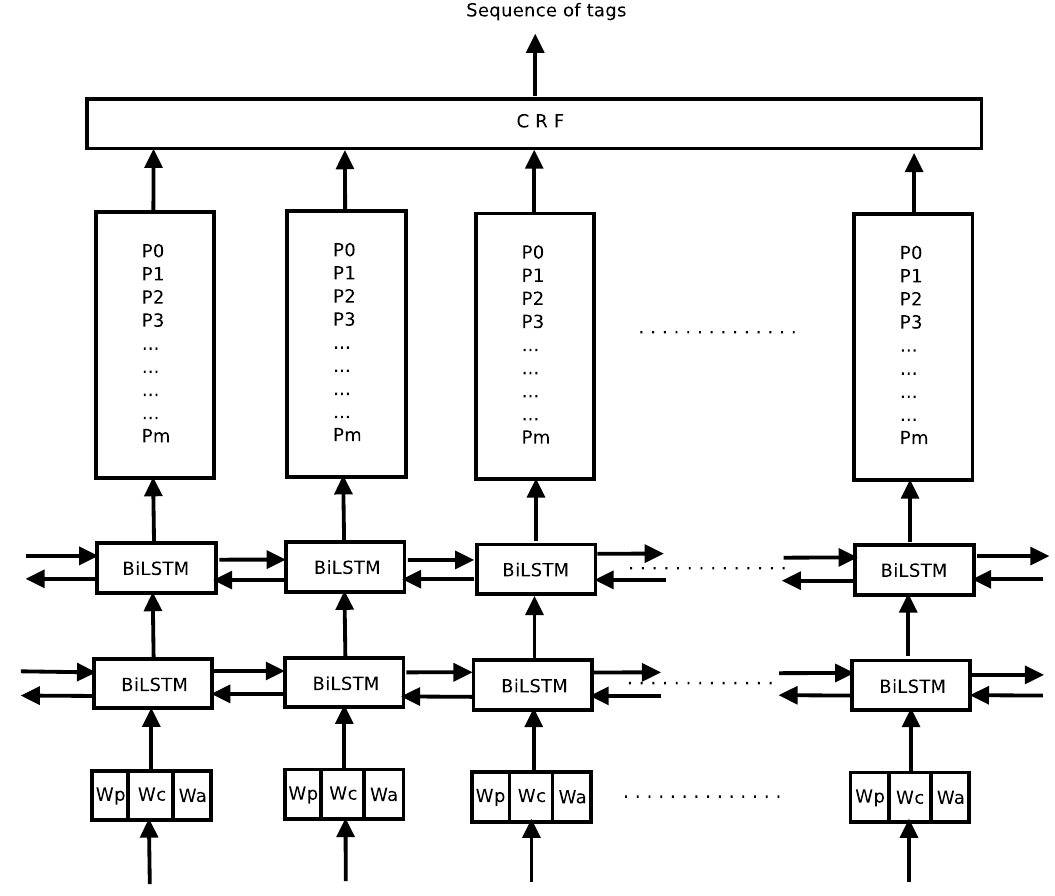
Figure 4. Architecture of the proposed